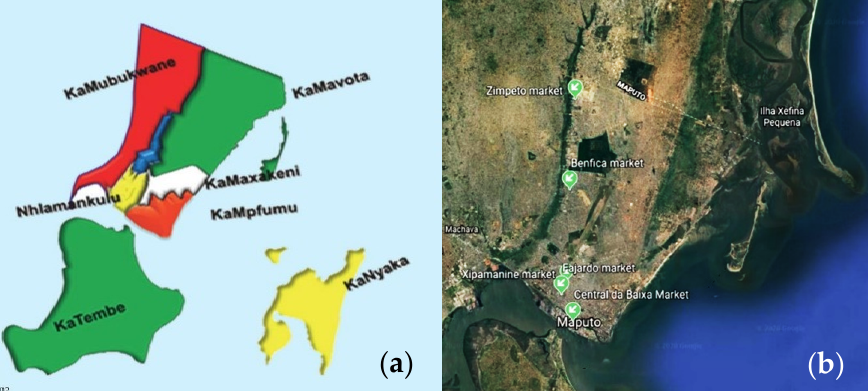
Figure 2. Sampling sites: ( a ) Map of municipal districts; ( b ) Markets sampled. Source: http://docplayer.com.br/12277474-Caderno-de-oportunidades-de-investimento-cidade-de- maputo.html.